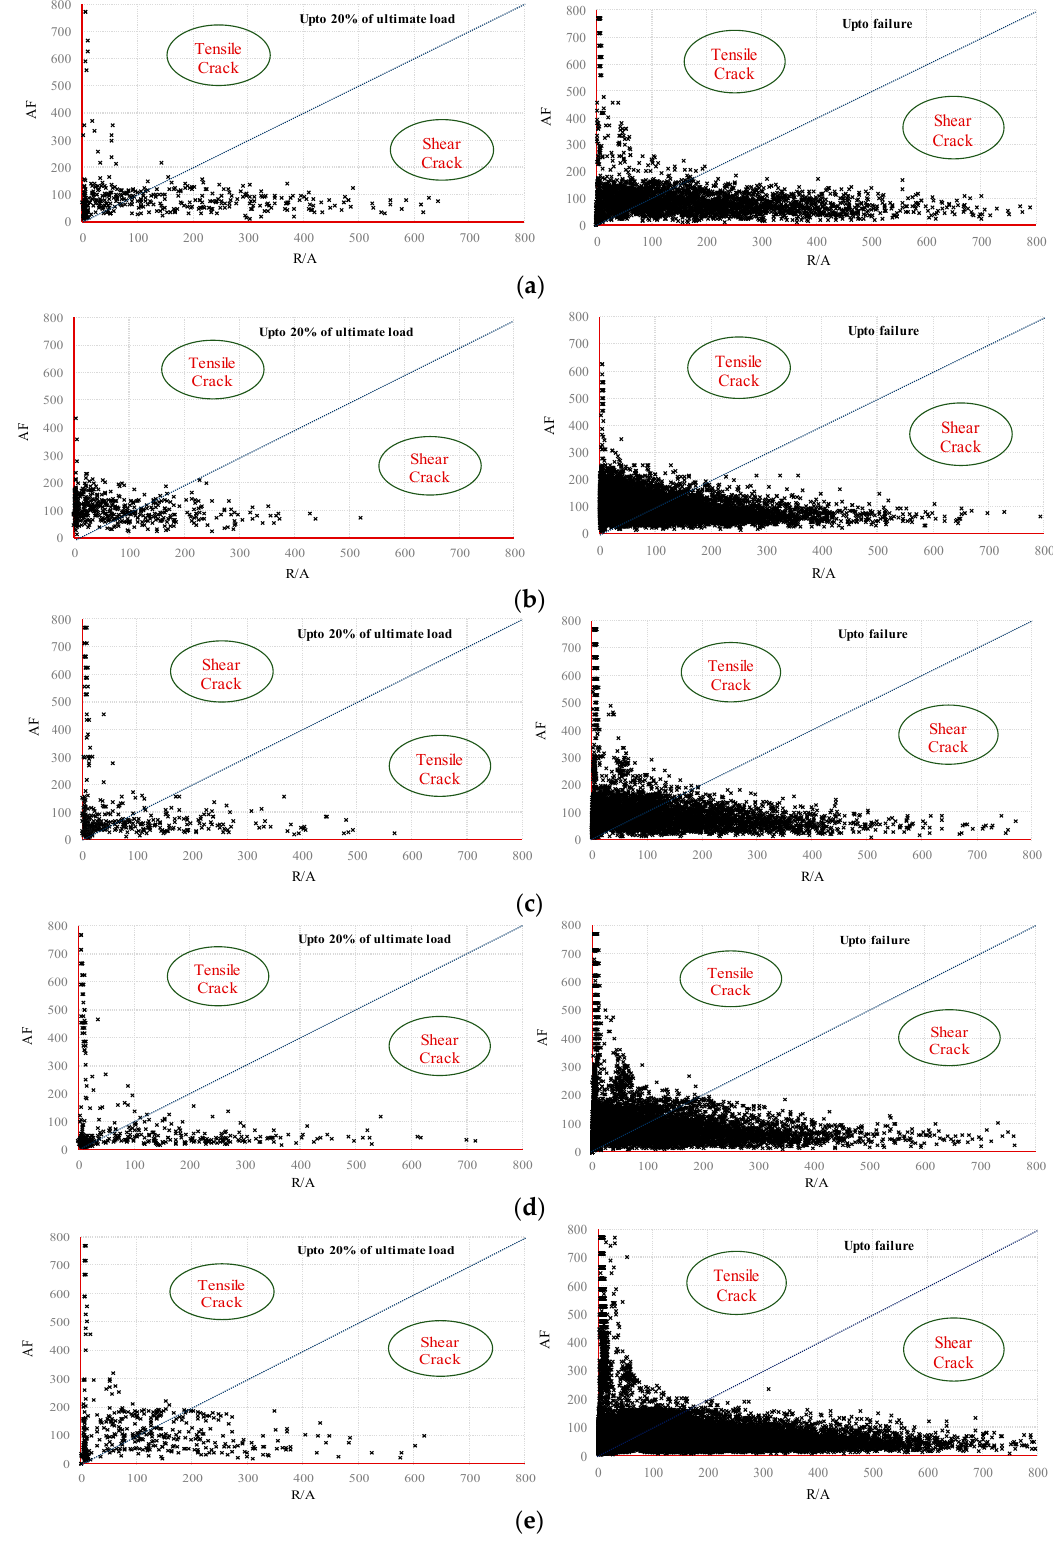
Figure 9. R / A-AF association diagram: ( a ) Uncorroded RC beam; ( b ) 10% corroded RC beam; ( c ) 20% corroded RC beam; ( d ) 30% corroded RC beam; ( e ) 40% corroded RC beam.